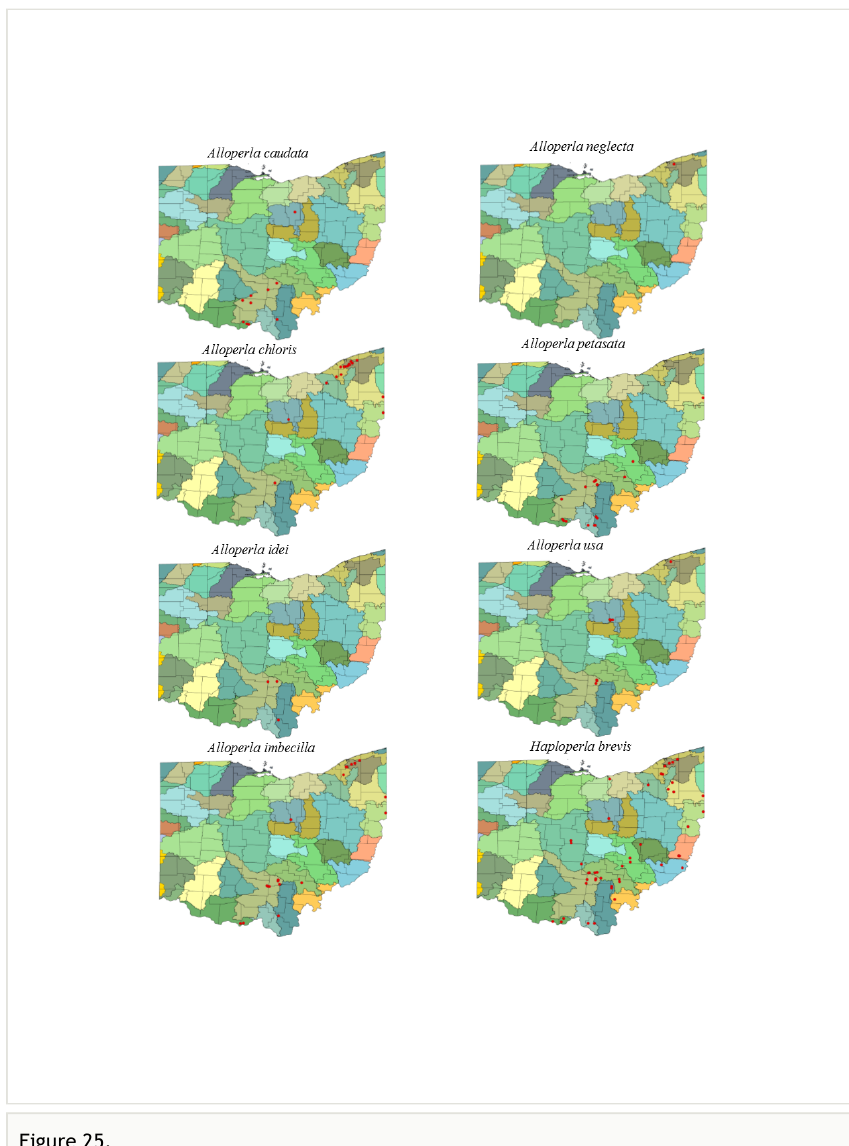
Figure 25. Distribution of Chloroperlidae in